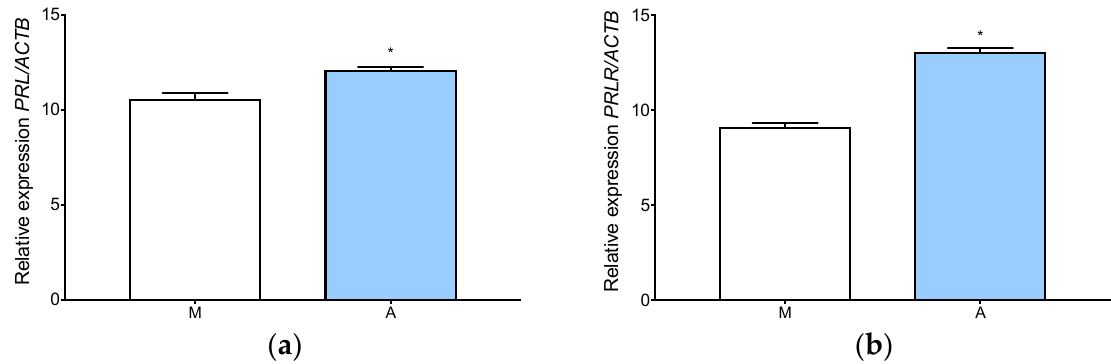
Figure 5. Prolactin and prolactin receptor expression in adenomyosis and normal myometrium. RT-qPCR analysis of PRL ( a ) and PRLR ( b ) expression of level in myometrium and adenomyosis. Each column represents the ratio of the expression of investigated gene and ACTB ± SEM. Asterisks indicate significant differences (* p ≤ 0.05). M, myometrium; A, adenomyosis.